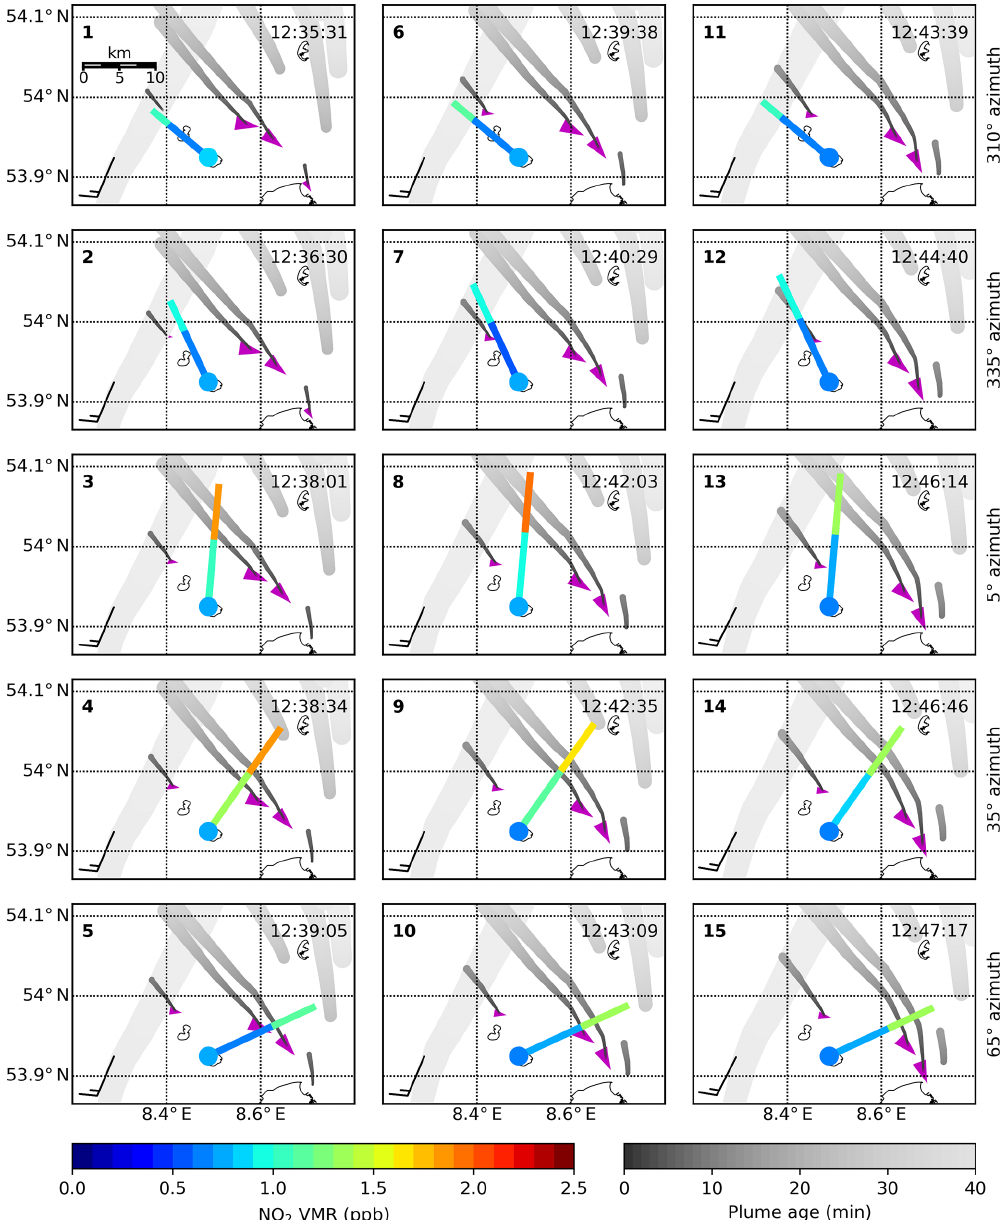
Figure 6. Sequence of maps showing 15 consecutive measurements in 0.5 ◦ elevation on 13 August 2014, starting at 12:35UTC (14:35LT). The extent of the UV path and (cid:49)L and corresponding path-averaged NO 2 VMRs are shown as colored lines. In situ NO 2 VMRs are shown as a colored dot at the location of the measurement site. Magenta triangles show the ship position and course (sharp tip), with larger triangles for larger ships. The modeled plumes are shown in gray, with the lightness of the gray shading representing the plume age. Wind direction and speed are shown with meteorological wind